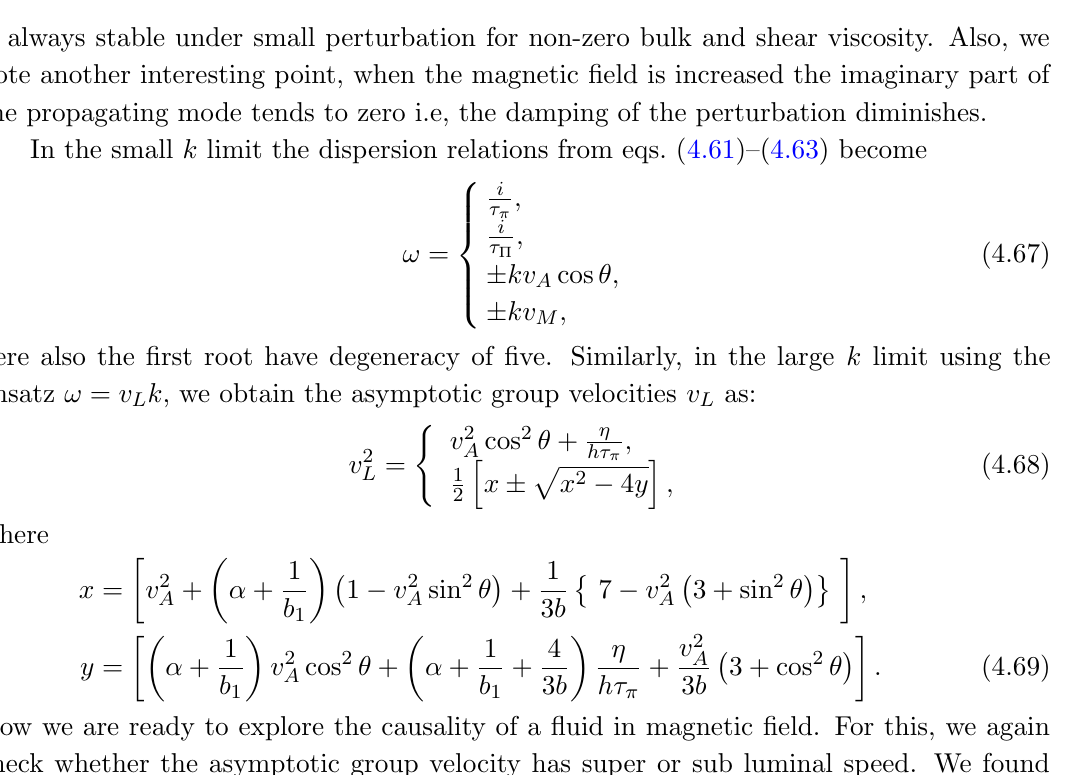
Figure 6 . (Color online) In the left panel = ( ! ) =T versus k=T and in the right panel group velocity as a function of k=T are plotted for di(cid:11)erent magnetic (cid:12)elds for (cid:18) = (cid:25) quartic equation with the coe(cid:14)cients eq. (4.66). The solid lines in the left panel corresponds to the propagating modes, the dashed lines and the dash-dotted lines correspond the non-propagating modes. The other parameters used here are a = a 1 = 0 : 1 ; T = 200 MeV ; (cid:28) (cid:5) = 0 : 985 fm and (cid:28) (cid:25) = 0 : 591 fm and kept constants for all the